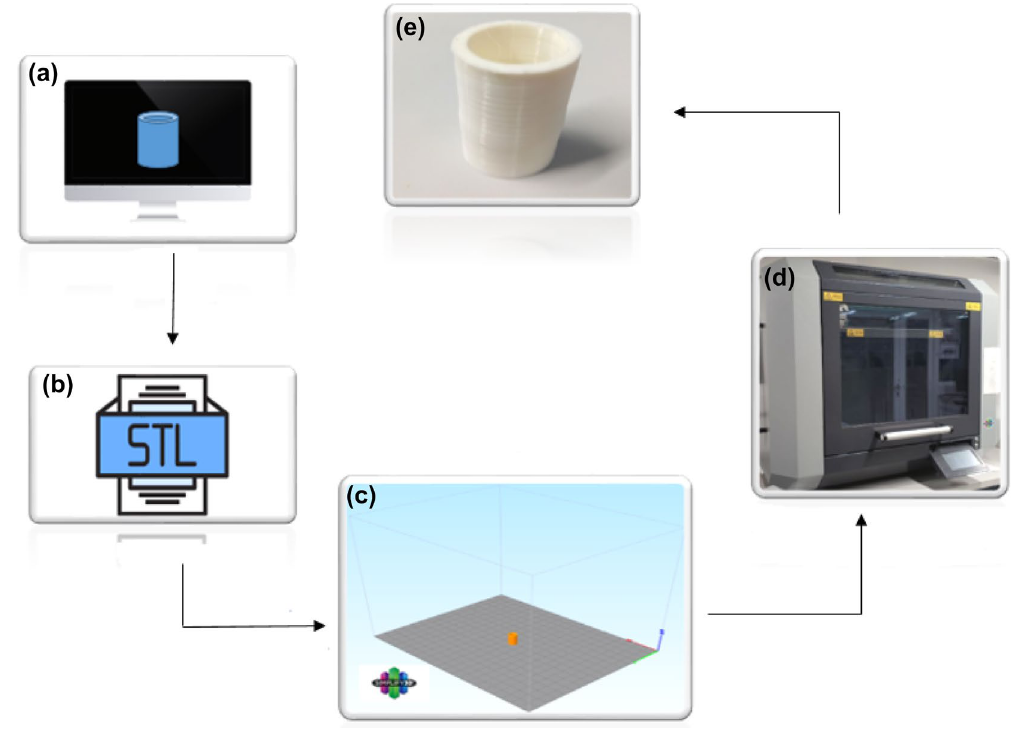
Figure 2. Schematic of 3D printing steps. ( a ) Creating a digital model, ( b ) converting the digital model to STL, ( c ) slicing and choosing the presses parameters, ( d ) printing the parts by German Rep Rap 3d printer, ( e ) 3d printed cylindrical parts.